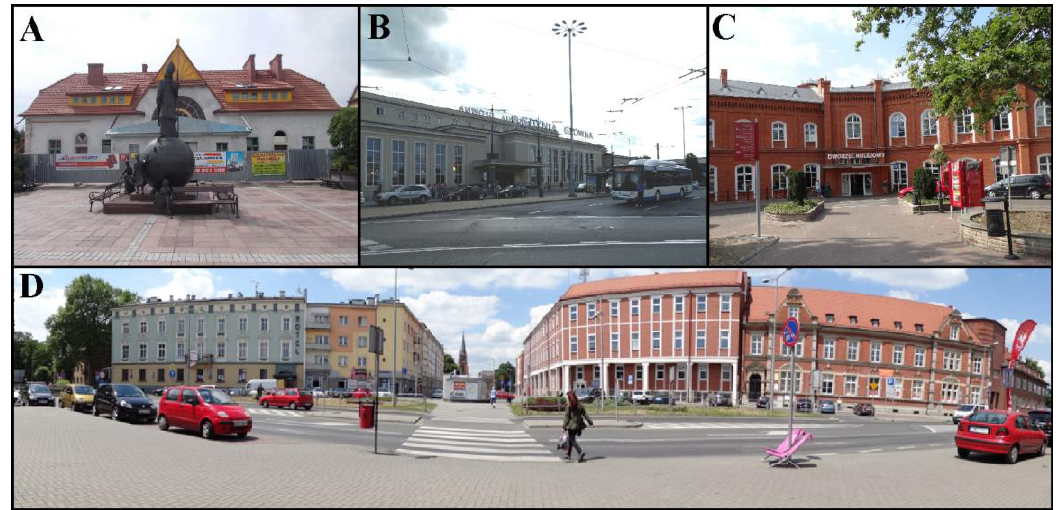
Fig. 4. Diversified spatial development around the edge railway station in Rabka Zdrój (A), Gdynia (B), Kostrzyn on the Oder (C) and Racibórz